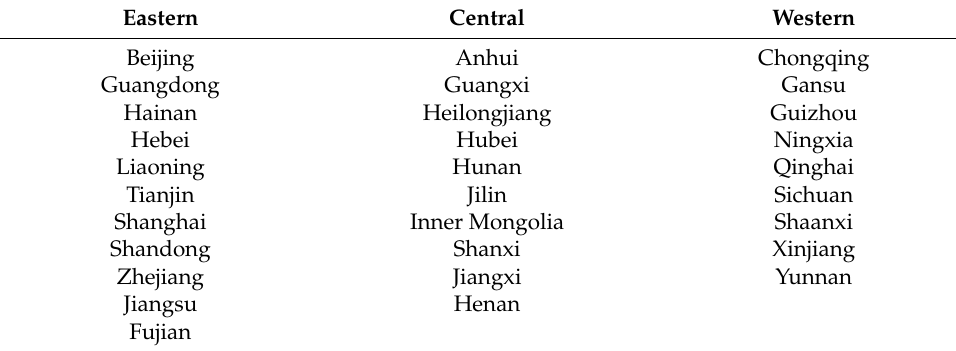
Figure 1. The groups based on technical heterogeneity of selected provinces in China. Table 1. The detailed grouping results of evaluated